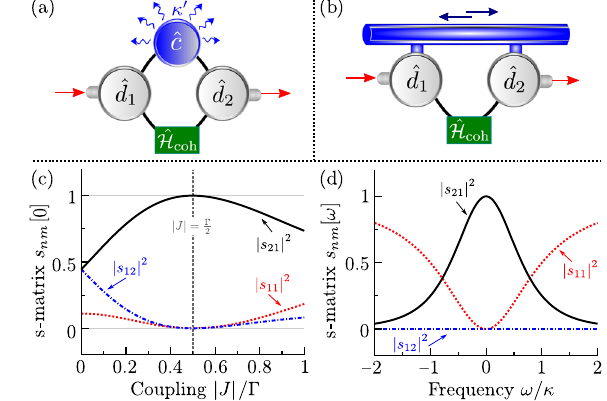
FIG. 2. (a) Realization of the engineered reservoir via an auxiliary cavity mode that is damped at a rate κ 0 . For strong damping κ 0 ≫ κ , this setup corresponds to a Markovian reservoir. (b) Implementation based on a transmission line, which supports propagation of photons in both directions. (c) Scattering matrix elements for the dissipative isolator setup at zero frequency, as a function of the coherent hopping J ; the phase of J is fixed so that arg ð J= Γ Þ ¼ π = 2 . When J is tuned as per Eq. (11), the system only allows directional transmission between cavities 1 and 2. We have fixed the dissipative coupling strength Γ to be equal to the cavity damping rate κ and have taken the Markovian limit for the engineered reservoir ( κ 0 ≫ κ ). (d) Scattering matrix elements as a function of frequency, when the directionality condition of Eq. (11) is fulfilled. In the Markovian limit, directionality holds over all